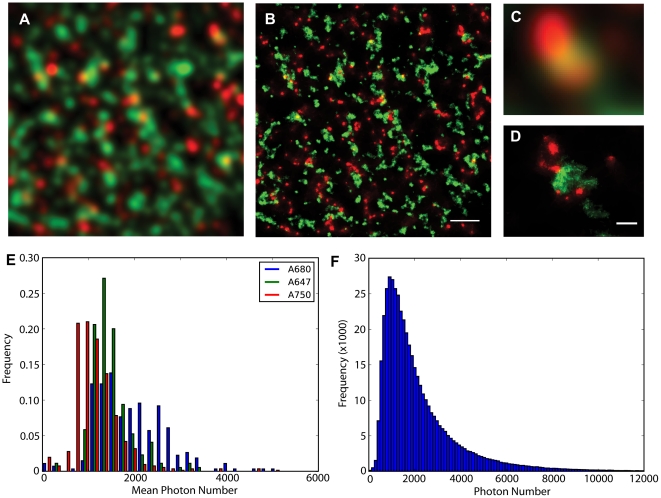
Two-dimensional super-resolution imaging of the distribution of Ryanodine receptors (red) and Caveolin (green), using Alexa 680 and Alexa 750 secondaries, in the periphery of isolated rat cardiac myocytes and overview of dye properties.Panel A shows the sample at conventional resolution, panel B the super-resolved image. Comparison of enlarged detail (C & D) shows that apparent overlap in the diffraction-limited images is not seen in the corresponding super-resolution image. E. Histogram of mean photon number per event of a dataset of ∼400 ratiometric super-resolution images. The mean photon numbers were calculated for each image in the dataset, the histogram of actual photon numbers per single molecule event are shown in panel F. Scale bars B: 1 µm, D: 200 nm.